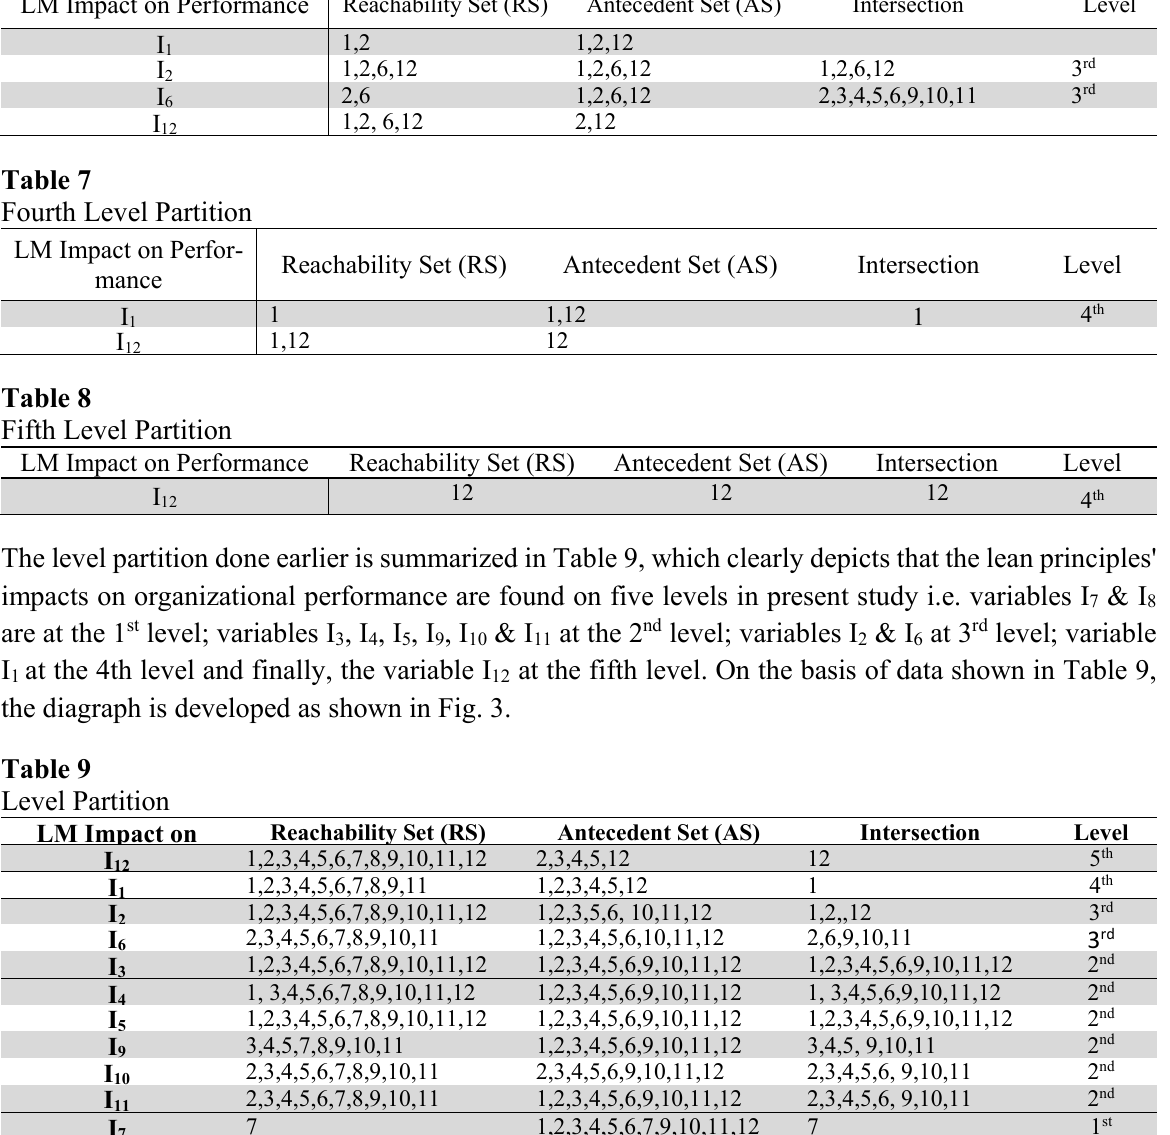
Third Level Partition LM Impact on Performance